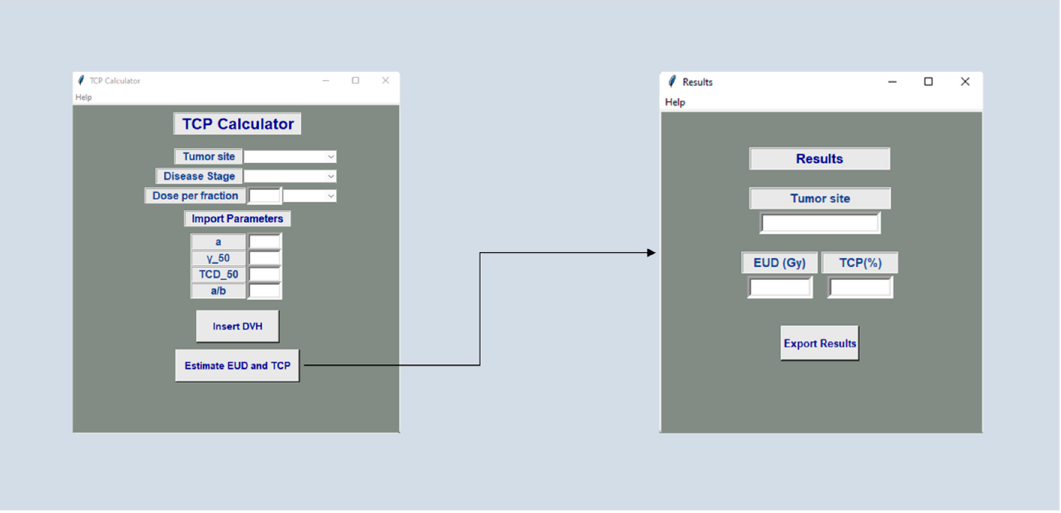
Figure 3. Software screen windows presenting the TCP calculation.